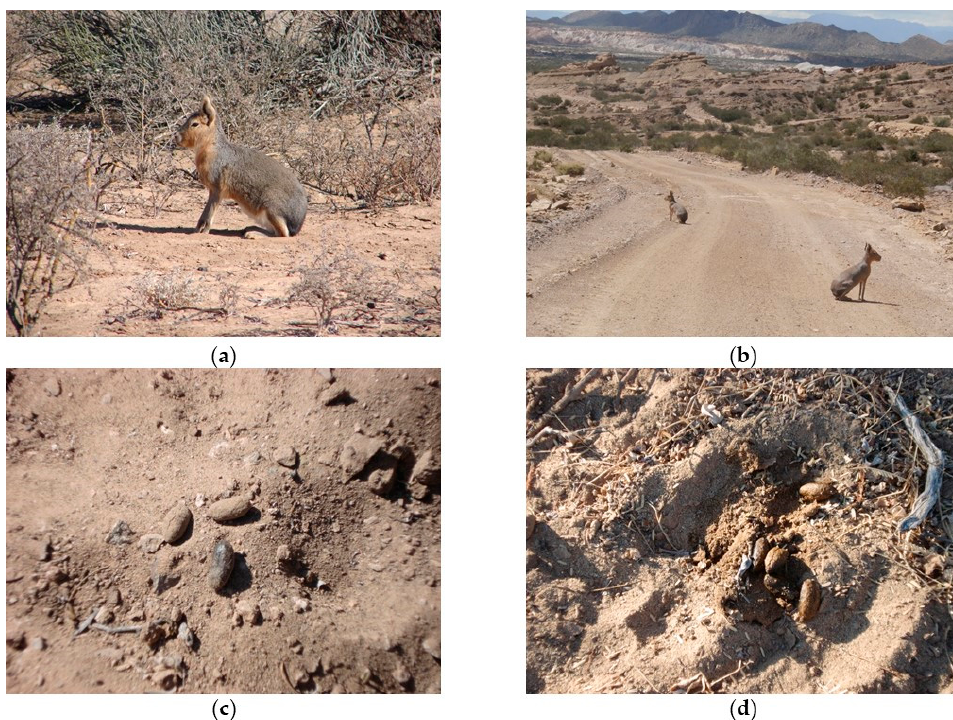
Figure 2. Photos of adults and feces of maras ( Dolichotis patagonum ) from the Ischigualasto Provincial Park, in San Juan, Argentina: ( a ) an adult; ( b ) a couple of maras sitting on the tourist dirt road; ( c ) feces detail; ( d ) a group of